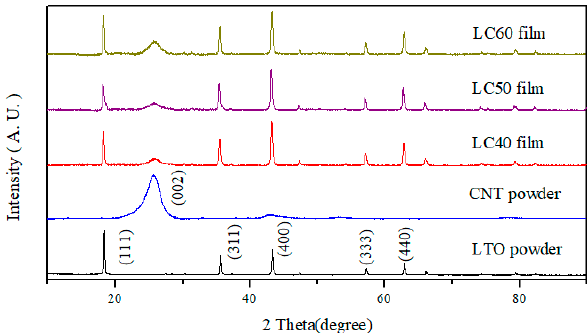
Figure 2. X-ray diffraction patterns of buckypaper, LTO, and the LC films.